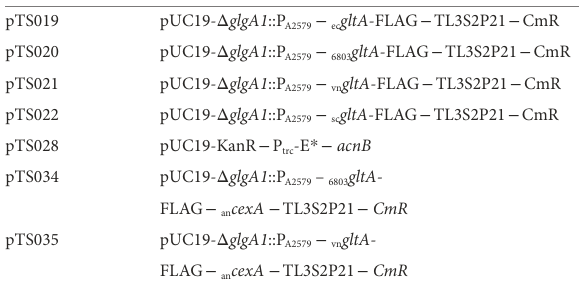
TABLE 1 Plasmids generated in this work. Plasmid name Plasmid